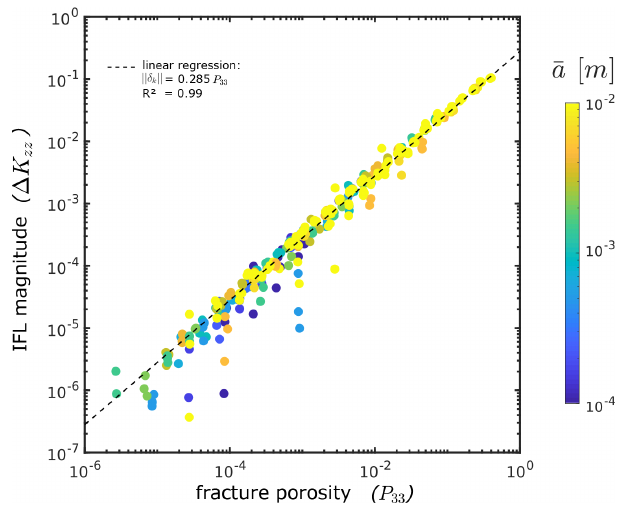
Figure 8. The figure demonstrates the difference between the verti- cal component of the permeability tensor (cid:49)K zz resulting from con- tinuum flow simulations of ECMs discretized with the fracture-and- pipe and fracture-only methods described in the text as a function of their respective global fracture porosities (i.e., their P 33 value). Colors indicate the constant hydraulic aperture of all fractures in the respective model. Note that high fracture densities are predomi- nantly reached for high fracture